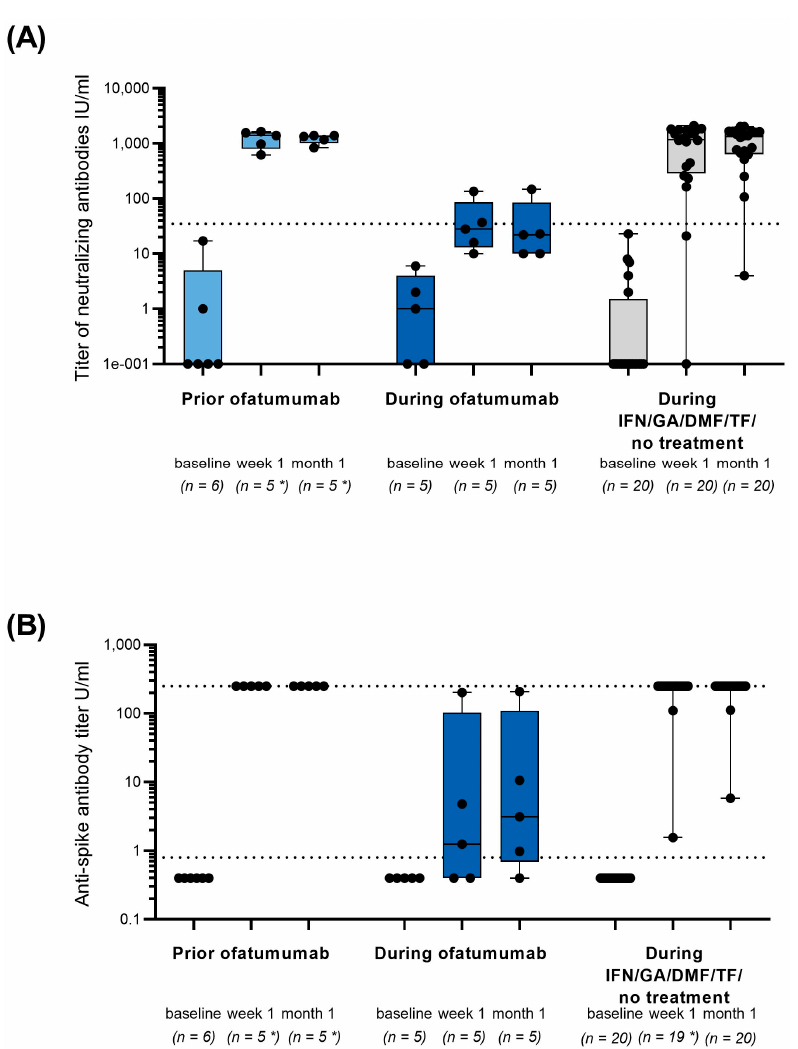
Figure 2. ( A ) Quantification of SARS-CoV-2-specific neutralizing antibody titer in U/mL after initial vaccination prior or during ofatumumab treatment. ( B ) SARS-CoV-2-specific serum total antibody titer in U/mL after initial vaccination prior or during ofatumumab treatment. * One patient in cohort